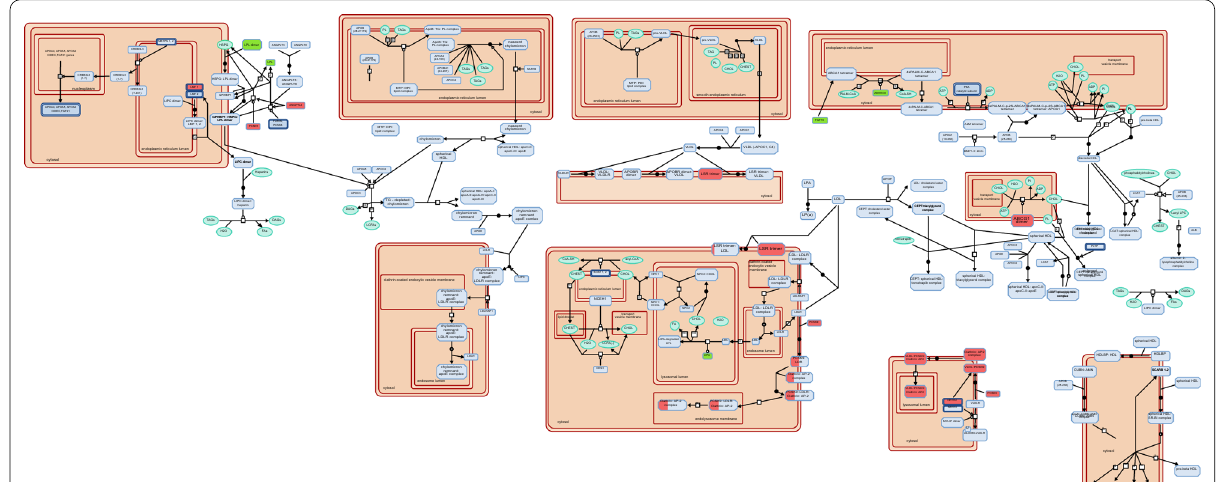
Fig. 1 The results of genes methylation in plasma lipoprotein pathway based on the Reactome Pathway Browser. Genes coloured in green were hypomethylated while hypermethylated are in red. Only promoters are